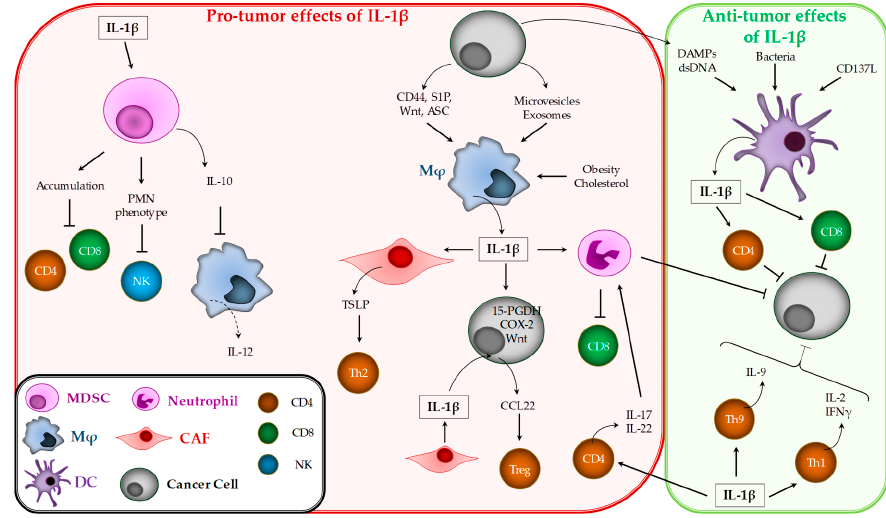
Figure 2. IL-1 β effects on pro- and anti-tumor immune response. TSLP, thymic stromal lymphopoietin; CAF, cancer-associated fibroblast; PGDH, hydroxyprostaglandin dehydrogenase; MDSC, myeloid-derived suppressor cells; PMN, polymorphonuclear; COX, cyclooxygenase; DAMPs, danger-associated molecular patterns; CCL, C-C motif chemokine ligand; IFN, interferon; NK, natural killer.